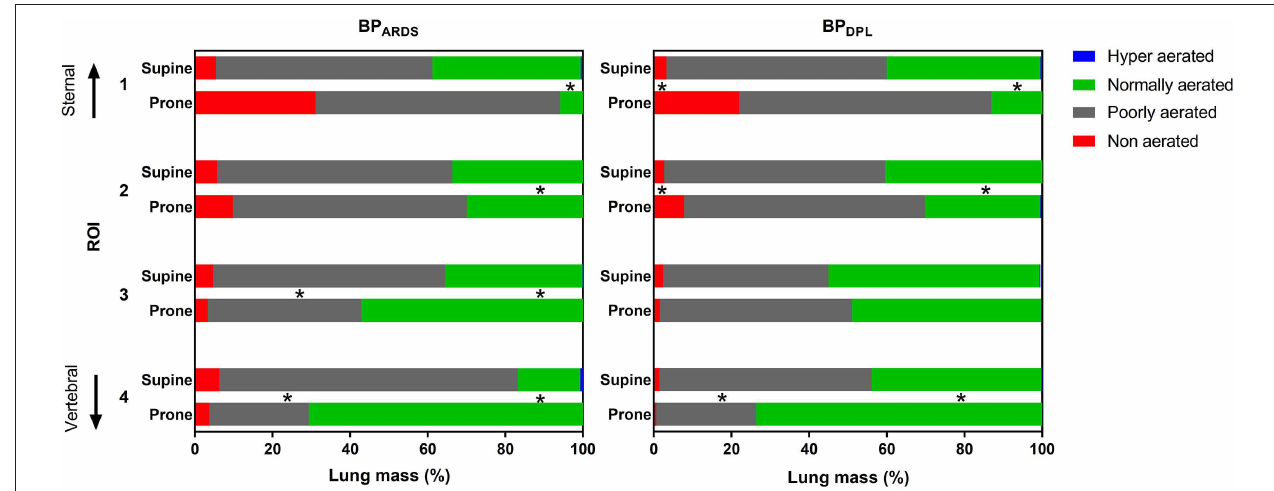
FIGURE 2 | Computed tomography regional aeration analysis. Bars represent the size of the aeration compartments in supine and prone positions (averaged between inspiratory and expiratory CT scan) with PEEP set according to BP ARDS (left panel) and BP DPL (right panel). Values are median (25th − 75th percentile). * p < 0.05 for the corresponding aeration compartment between prone and supine using the same PEEP titration